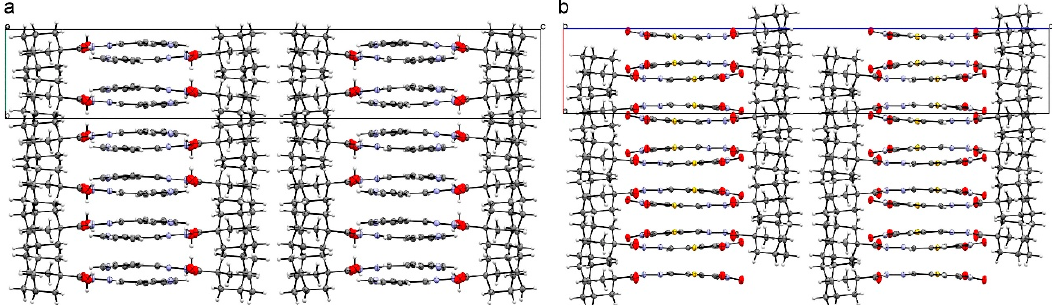
Figure 4. View of crystal packing of compound 1 along the crystallographic a axis ( a ) and compound 2 along the crystallographic b axis ( b ).